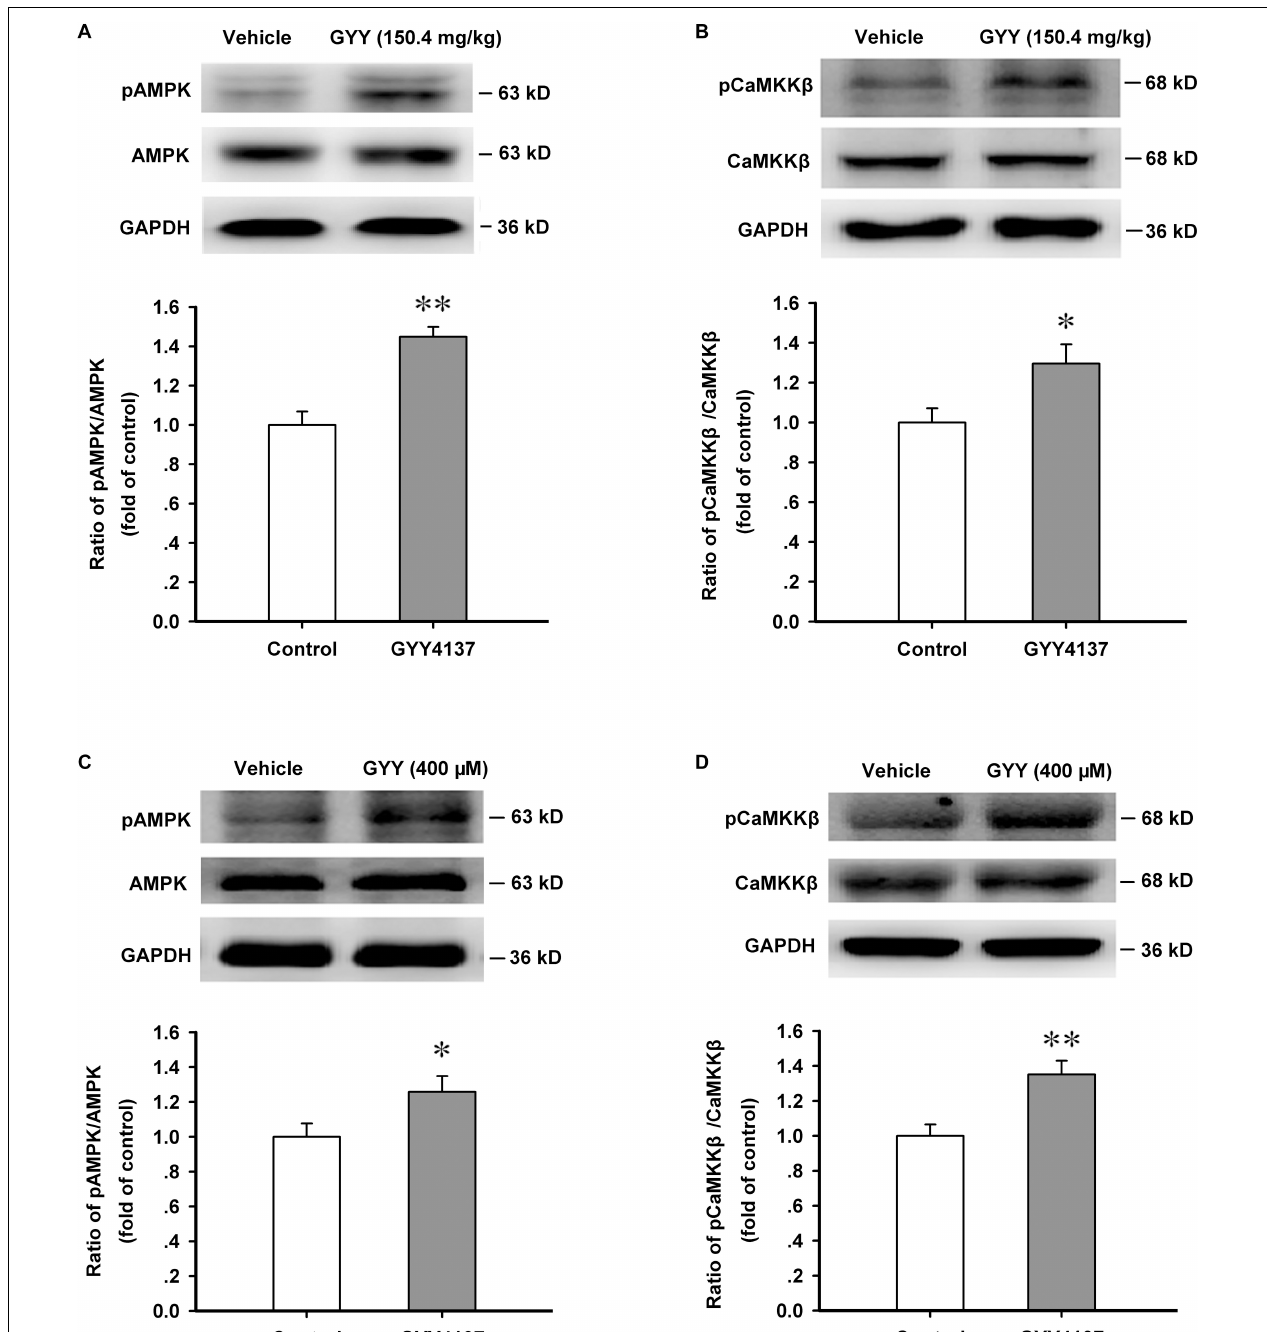
FIGURE 3 | GYY4137 enhances the activation of AMPK and CaMKK β in ARC tissue and neurons. (A) Western blot assay showing that GYY4137 (150.4 mg/kg) increased the activation level of AMPK in ARC tissue ( n = 5). (B) GYY4137 (150.4 mg/kg) increased the activation level of CaMKK β in ARC tissue ( n = 6). (C) GYY4137 (400 µ M) increased the activation of AMPK in primary culture of ARC neurons ( n = 5). (D) GYY4137 (400 µ M) increased the activation of CaMKK β in primary culture of ARC neurons ( n = 5). Data are normalized as folds to control and expressed as means ± SEM. One-way ANOVA was used. ∗ P < 0.05, ∗∗ P < 0.01 vs